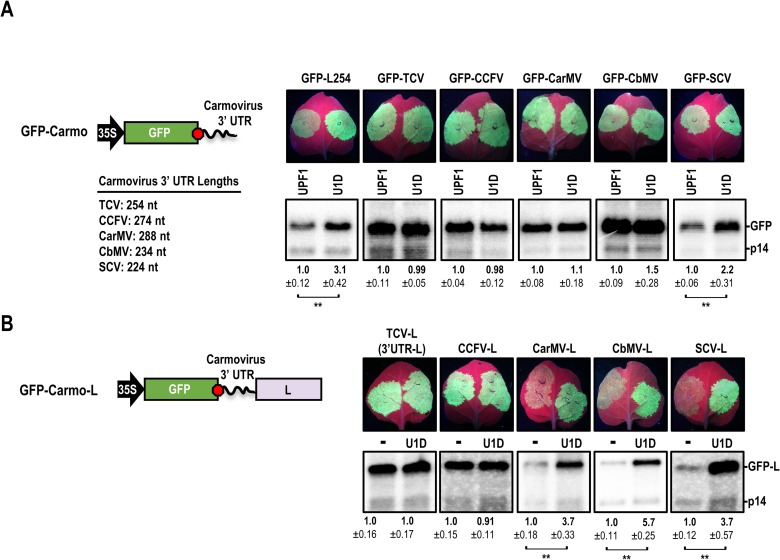
3’ UTRs of TCV and CCFV confer efficient protection against NMD.(A) TCV, CCFV, CarMV, CbMV, and SCV 3’ UTRs were placed downstream of GFP. A 254-nt sequence derived from the “L” ORF was used as a control (GFP-L254). Constructs were agroinfiltrated with constructs expressing either UPF1 or U1D along with p14. Only GFP-L254 and GFP-SCV showed increased RNA accumulation with U1D. (B) The carmovirus 3’ UTRs were inserted into GFP-L to determine if strong NMD-resistance could be conferred. Constructs were agroinfiltrated with constructs expressing either mock (-) or U1D along with p14. Data from both panels are from three infiltrated leaves. Standard deviation is shown. See legend to Fig 2B for more information.